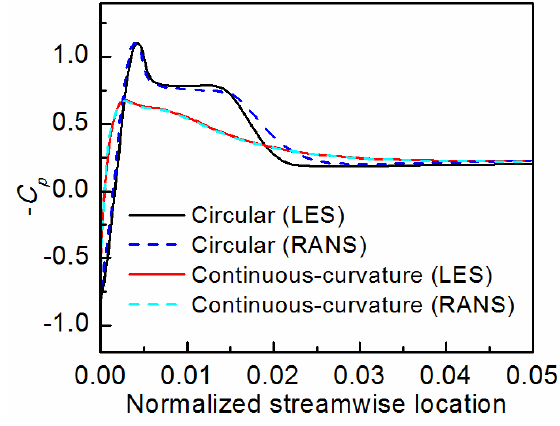
Figure 24. Time-averaged pressure distributions at mid-span.